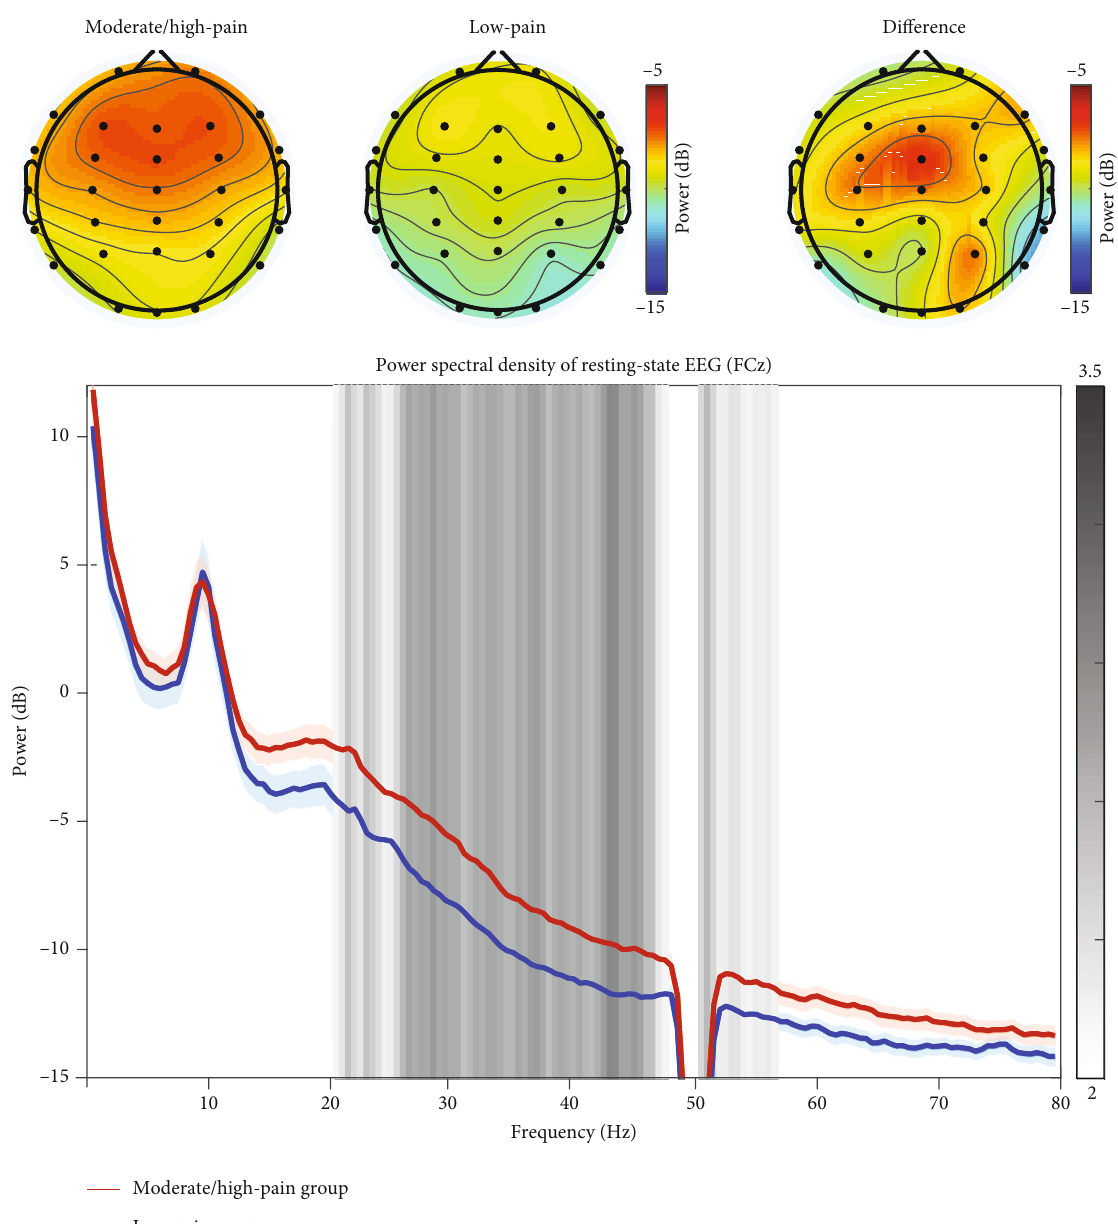
Figure 2: The di ff erence of spectral power density of resting-state neural oscillations between patients with di ff erent levels of acute postoperative pain, i.e., moderate/high pain and low